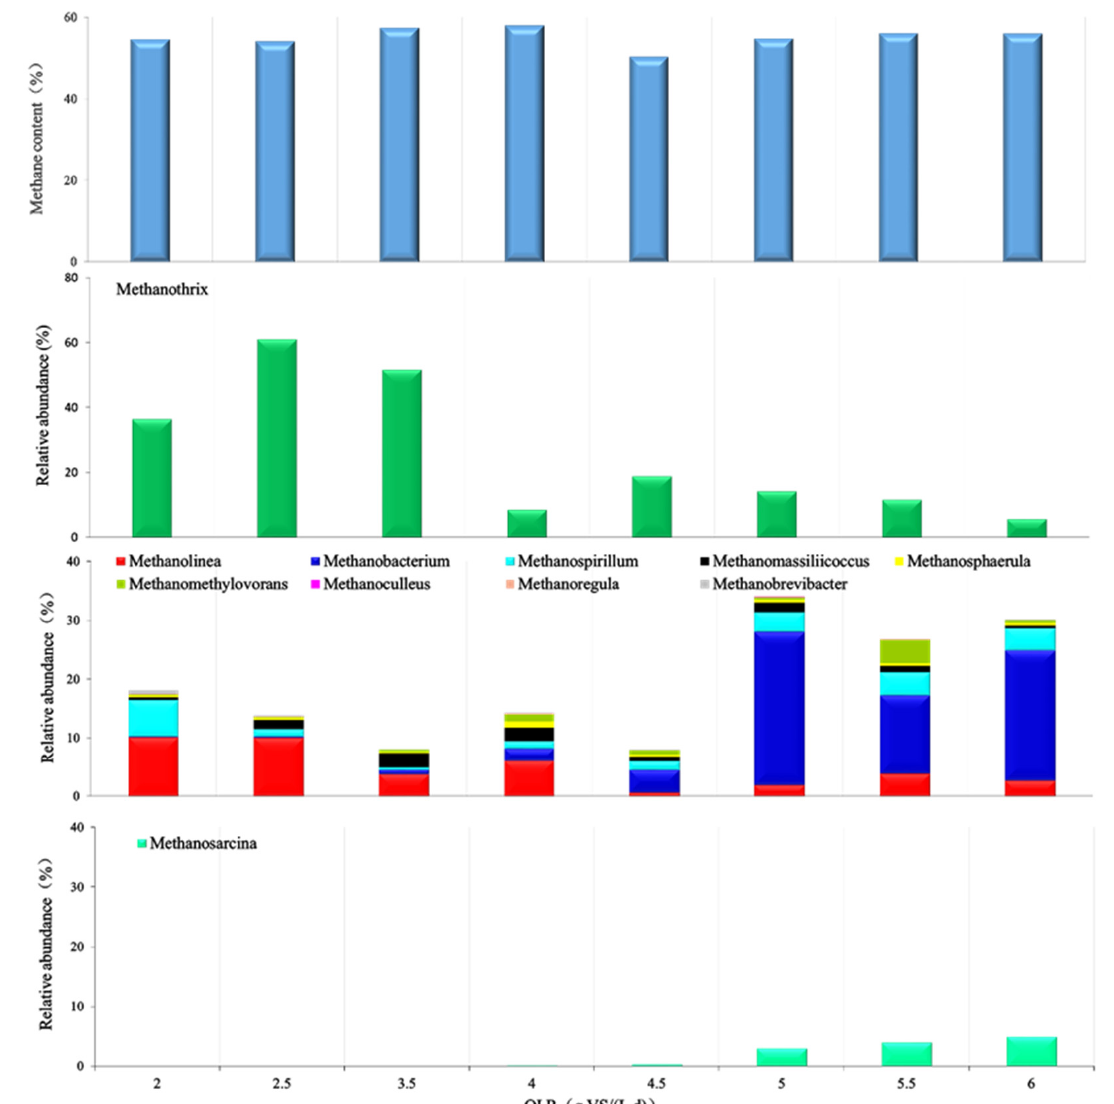
Figure 3. Methane contents and the methanogens in genus level for GM11.